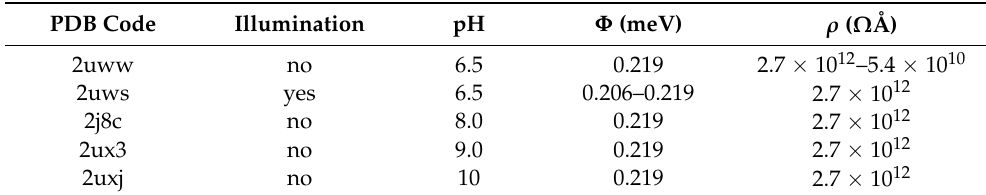
Table 1. List of the analyzed b RC structures. Each structure is identified by a code in the Protein Data Bank [10,11]; illumination conditions and the pH value of the solution in which they were crystallized are reported. The values of the barrier height, Φ , used for the I - V calculations, as well as of the link resistivity, ρ , used in the impedance calculations are reported. PDB Code